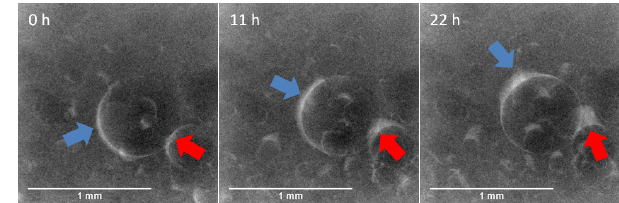
Figure 5. Vertically sliced X-ray images of a 1.0mM CsCl ice (lab- oratory freezer, voxel resolution ∼ 2µm) after 0, 11, and 22h in the CT sample chamber. Lighter tones indicate areas of higher ra- diodensity (e.g., greater CsCl amounts). Air bubbles are visible as darker gray spheres. The temperature of the sample holder was set at − 10 ◦ C, but the top of the sample was approximately 1.3 ◦ C warmer than the bottom, corresponding to a temperature gradient of approx- imately 0.13 ◦ Cmm − 1 . Arrows highlight two of the areas where CsCl moves along the direction of the temperature gradient, from colder to